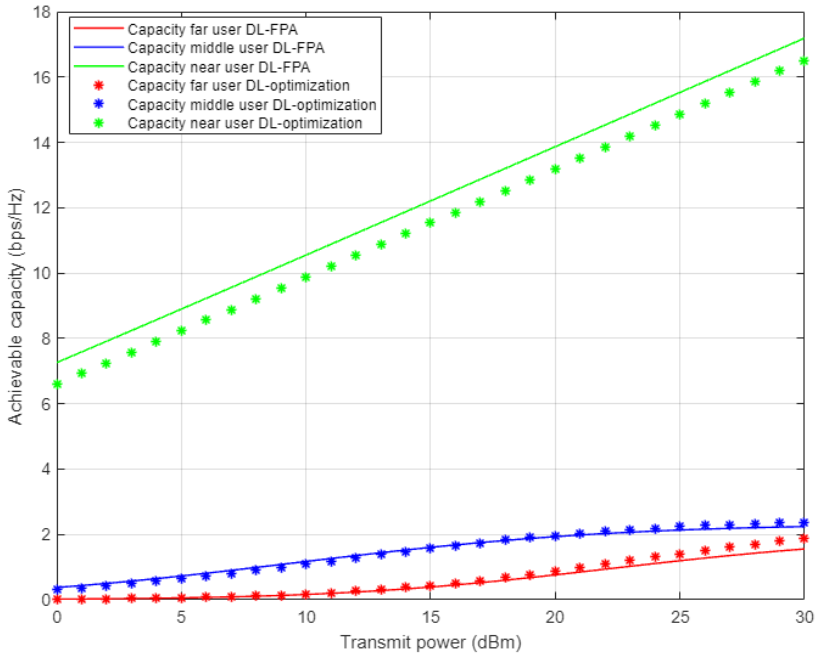
Figure 15. Individual capacity vs. power for DL-based optimized and FPA power schemes (Rayleigh Channel).